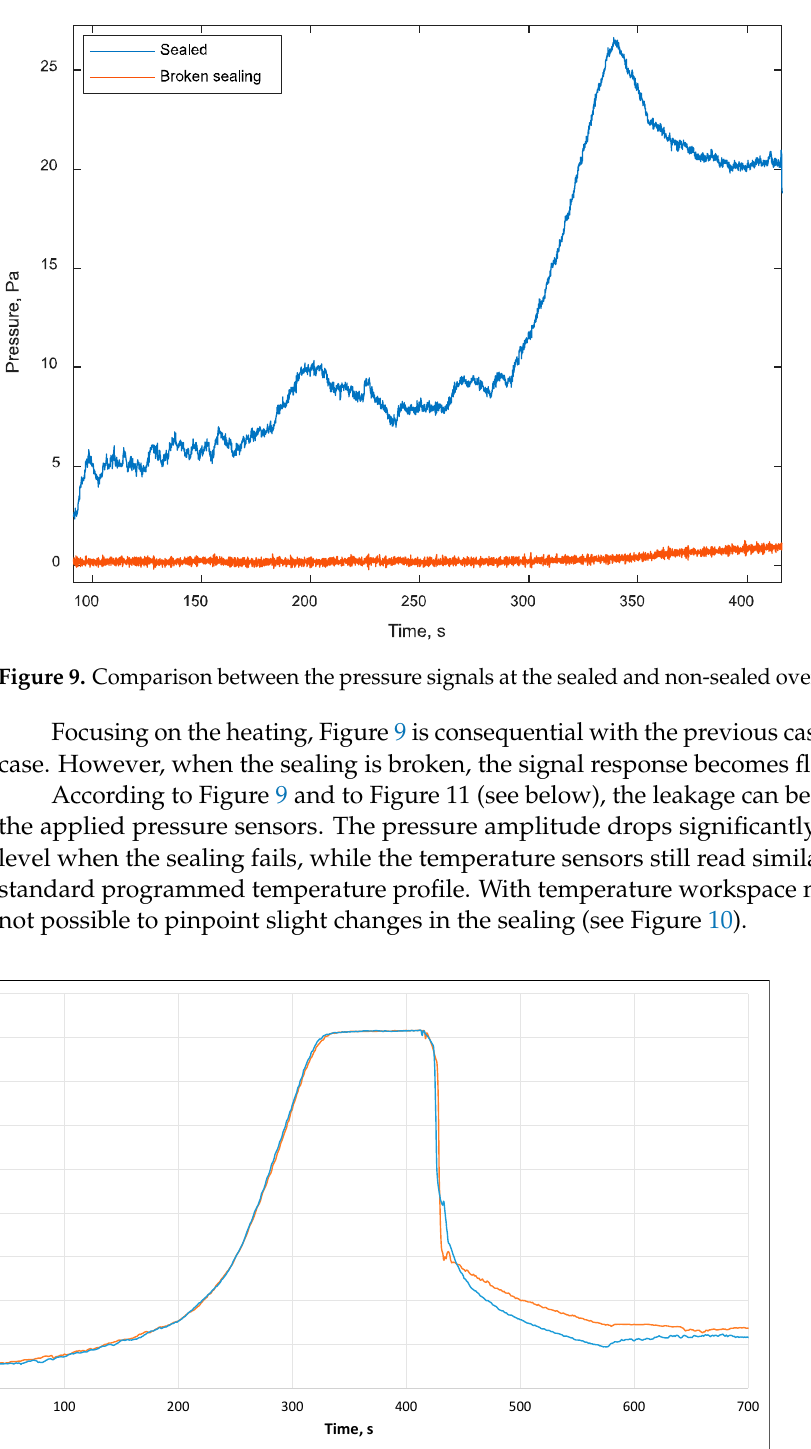
Figure 11. The profiles of the pressure and temperature in a hermetically and non-hermetically sealed oven. 4. Conclusions This paper presents the versatile and novel application of gauge-type pressure sen- sors in heat-level—vapour phase soldering (HL-VPS) ovens. It was shown in a commer- cially available VPS oven that the gauge-type sensors could reveal the time point of va- pour saturation at the PCB level and the state of the saturated vapour column precisely, improving the characterization of the VPS reflow process.